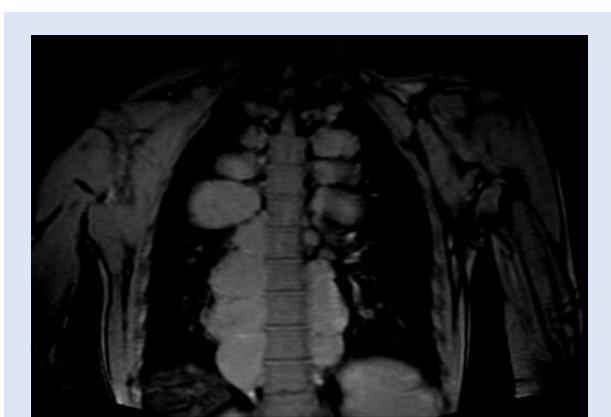
Fig. 4. Coronal T3-weighted sequence shows lobulated masses extending laterally into the posterior mediastinum, with similar signal to the adjacent vertebral